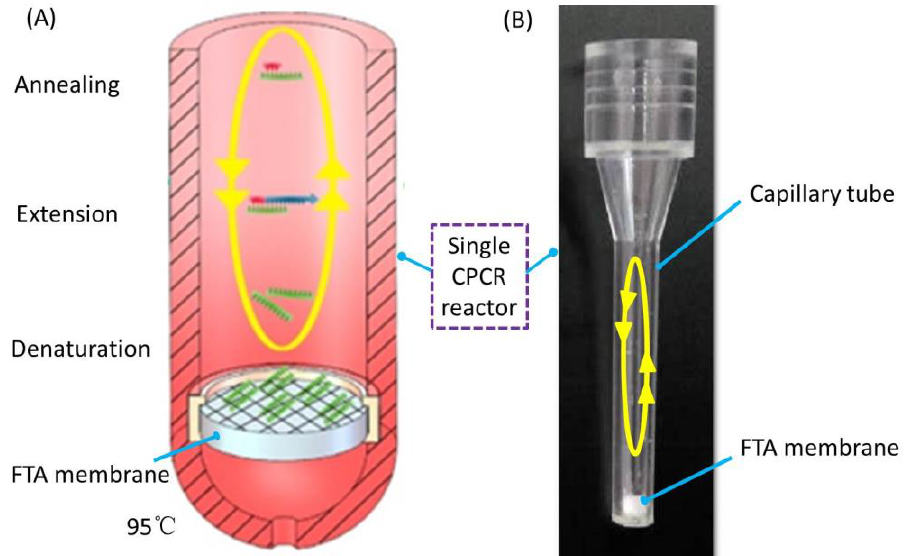
Figure 1. Single CPCR reactor equipped with a solid phase membrane for sample preparation. ( A ) Schematic depiction of real-time CPCR with an FTA membrane; ( B ) a photograph of capillary tube equipped with an FTA